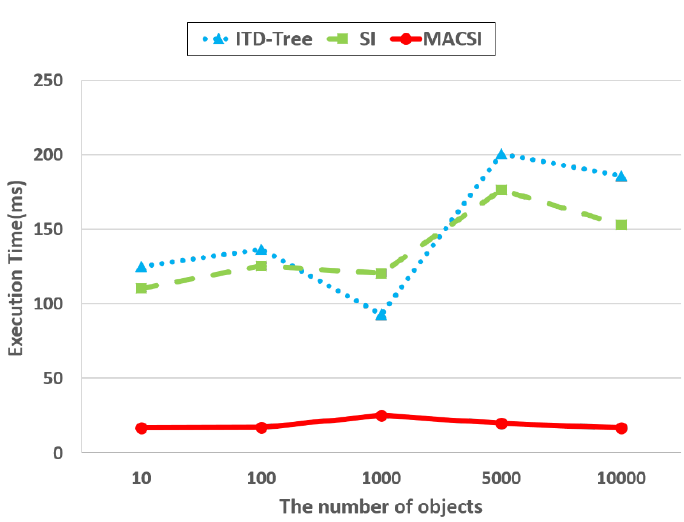
Figure 29. The effect of object number on the update performance.